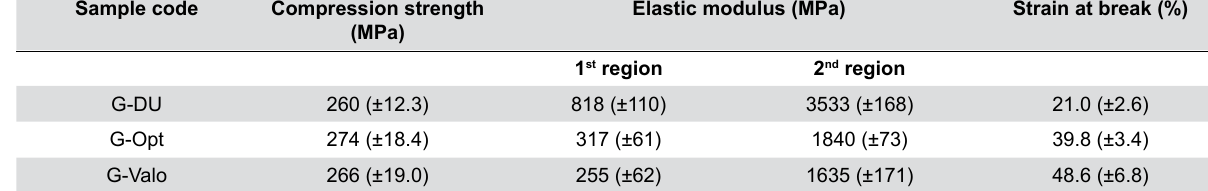
Table 2- Elastic modulus, compressive strength values of the samples